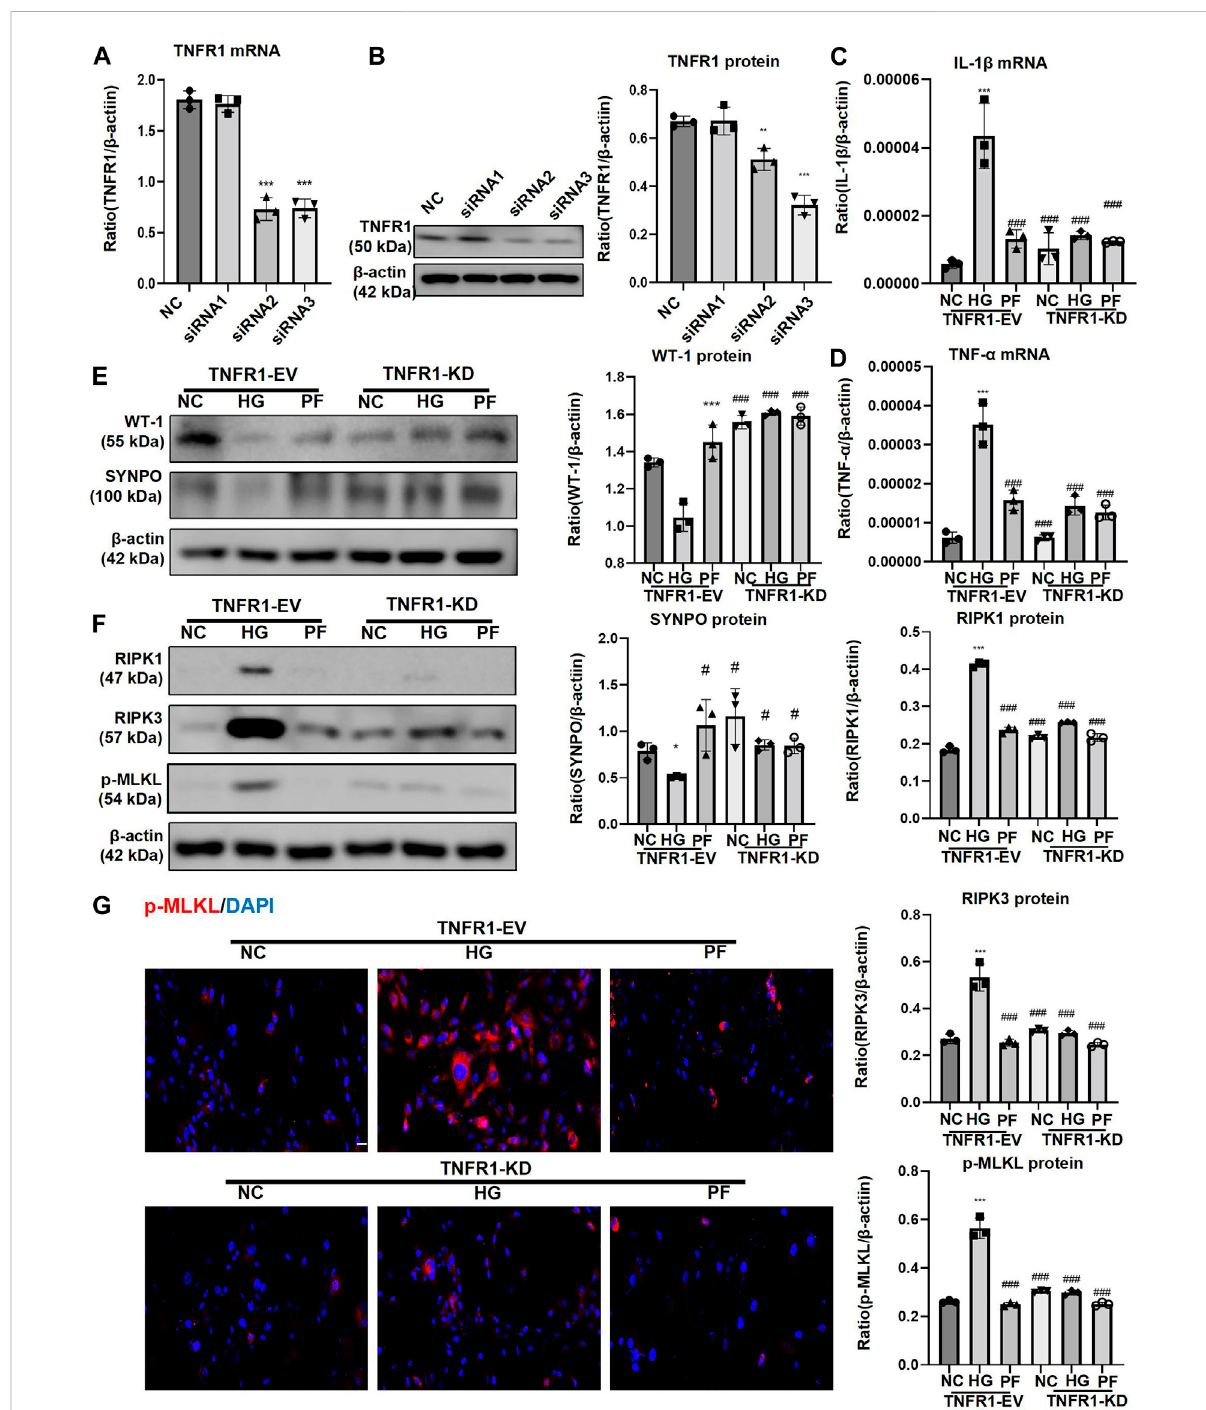
FIGURE 10 PF regulates podocyte necroptosis via TNFR1. (A) Real-time PCR assay of TNFR1 in MPC5 cells after TNFR1 knockdown. (B) WB assay of TNFR1proteininMPC5cellsafterTNFR1knockdown. (C) ThechangeofIL-1 β mRNAinMPC5cellsafterTNFR1knockdown. (D) ThechangeofTNF- α mRNA in MPC5 cells after TNFR1 knockdown. (E) WB assay of WT-1 and SYNPO proteins in MPC5 cells after TNFR1 knockdown. (F) WB assay of necroptosis-related proteins in MPC5 cells after TNFR1 knockdown. (G) IF staining of p-MLKL proteins expression in MPC5 cells after TNFR1 knockdown. Scale bar = 50 μ m. Results represent the mean ± SD. * p < 0.05, *** p < 0.001 vs. NC; # p < 0.05, ## p < 0.01, ### p < 0.001 vs. HG. NC, normal control (5.5 mmol/L glucose); HG, high glucose (40 mmol/L); PF, paeoni fl orin; TNFR1, tumor necrosis factor receptor 1; IF, immuno fl uorescence; WB, Western blotting; MPC5, mouse podocyte clone 5; TNF- α , tumor necrosis factor- α ; WT-1, Wilms tumor 1 protein; SYNPO, synaptopodin; RIPK1, receptor-interacting serine/threonine kinase 1; RIPK3, receptor-interacting serine/threonine kinase 3; MLKL, mixed- lineage kinase domain-like